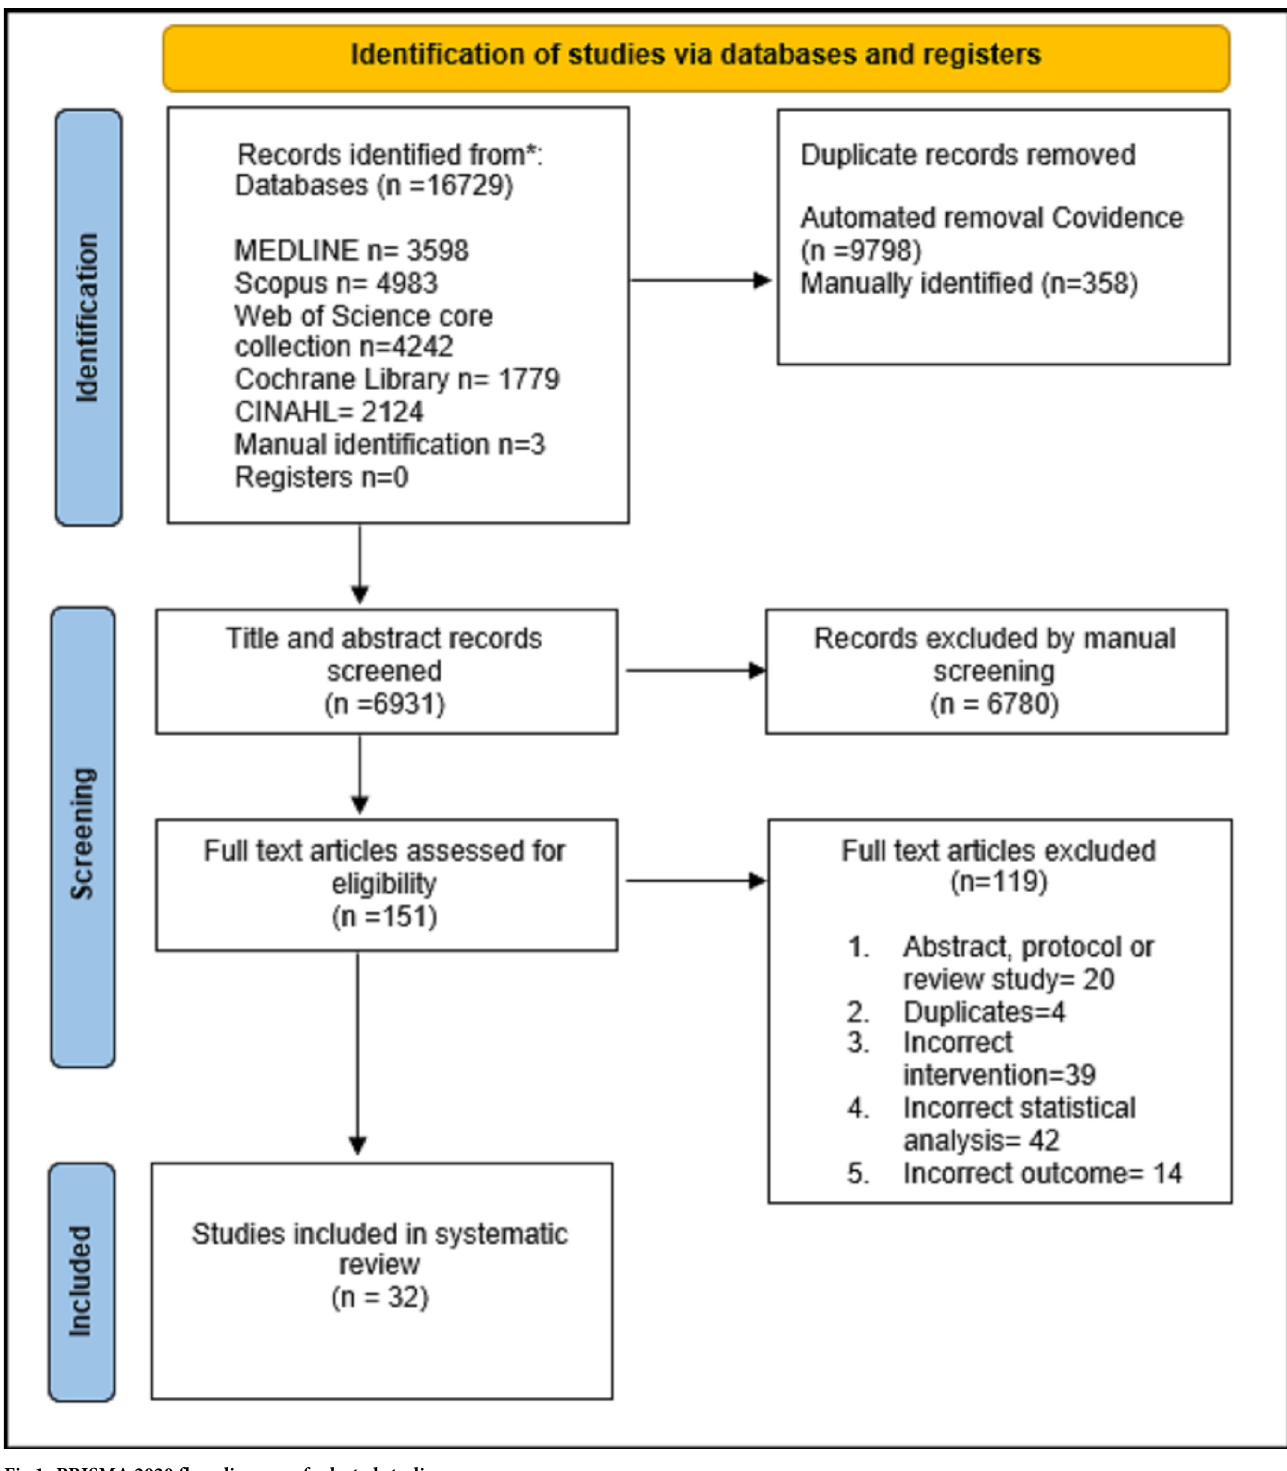
Fig 1. PRISMA 2020 flow diagram of selected studies.